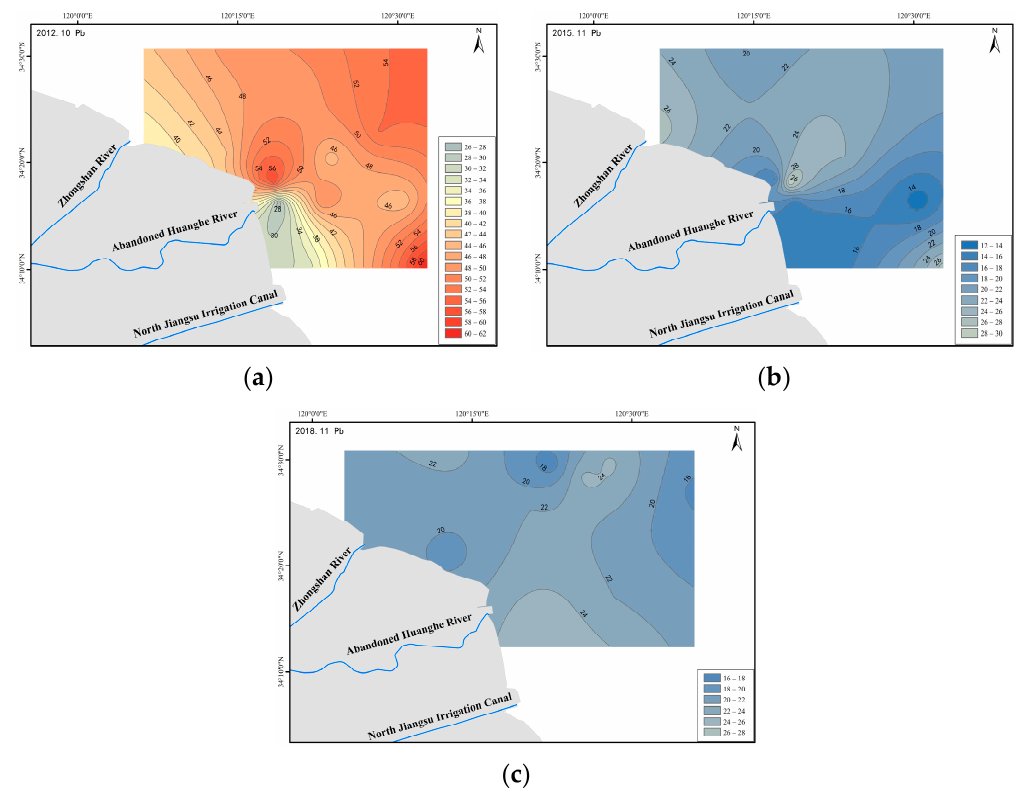
9 of 15 Figure 6. Cluster analysis results in 2015. Figure 7. Cluster analysis results in 2018. 3.3.3. Spatial Variation of Heavy Metals in Sediments From 2012 to 2018, the contents of many heavy metals either declined or remained at the same level as that detected in previous years. However, Cd showed a significant up- ward trend. The content of Cr was low during the monitoring periods and mainly origi-